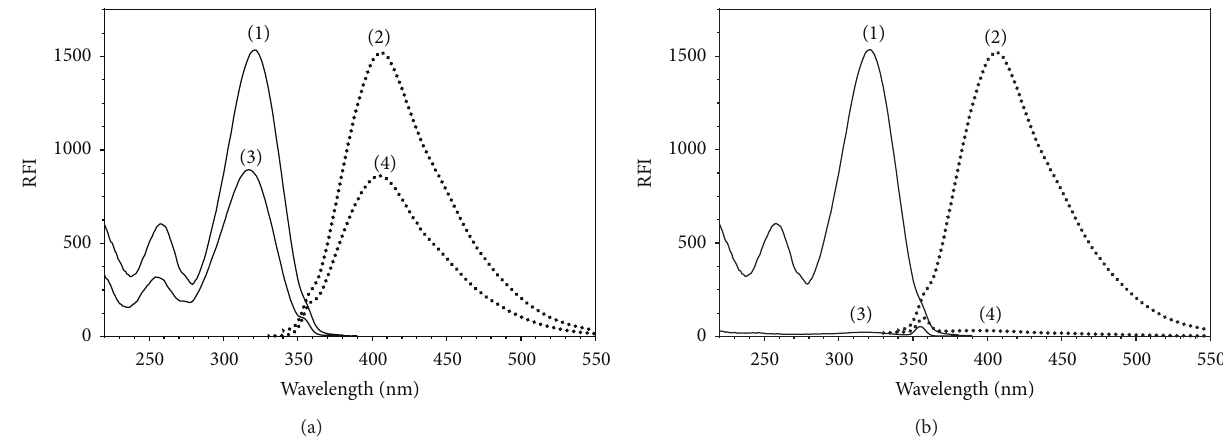
Figure 2: Excitation (1) and emission (2) spectra of MRZ (100ng/mL) in SLS (1%, w/v); (a) excitation (3) and emission (4) spectra of MRZ (100ng/mL) in acidic aqueous solution; (b) excitation (3) and emission (4) spectra of SLS (1%, w/v) in water.